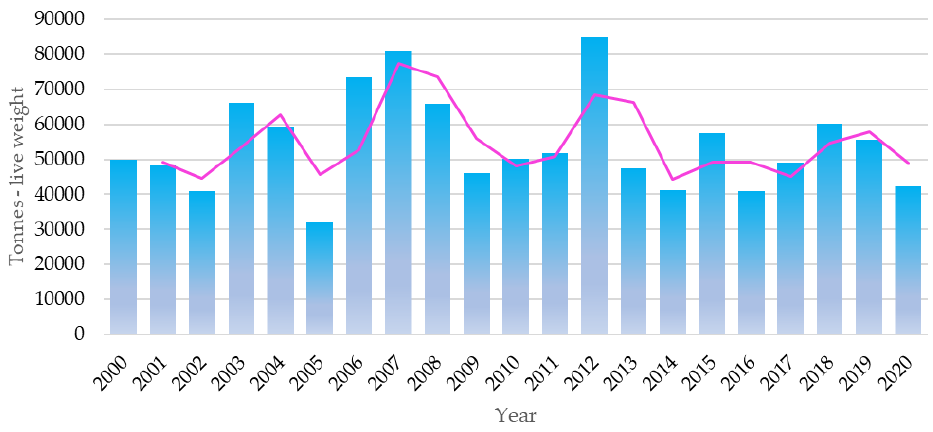
Figure 1. Global capture production of striped venus ( Chamelea gallina ) from 2000 to 2020. The purple line indicates the moving average value ([4,5] FishStatJ v. 4.02.06).